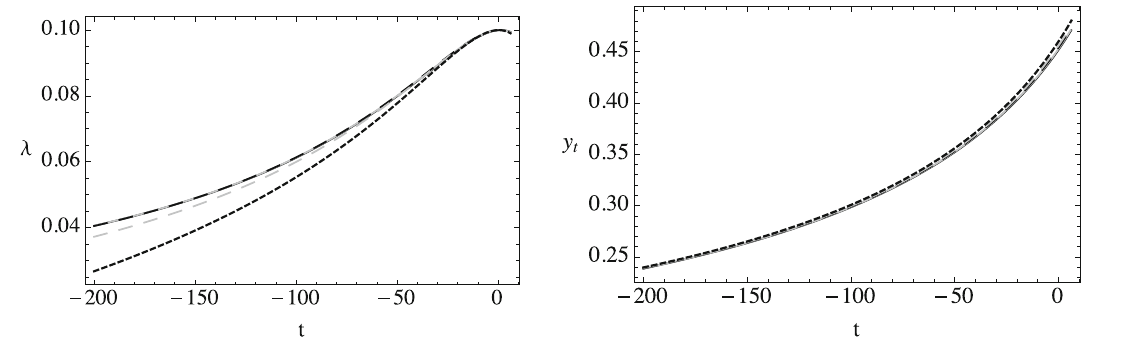
Fig. 6 Running for matter couplings λ and y t in left and right, respec- tively. These are plotted for f 2 ∗ = 10 − 8 , λ ∗ = 0 . 1, ρ ∗ = 1 . 5 and (cid:2) = 10 − 16 . We considered the following initial conditions for ξ ∗ = 10 2